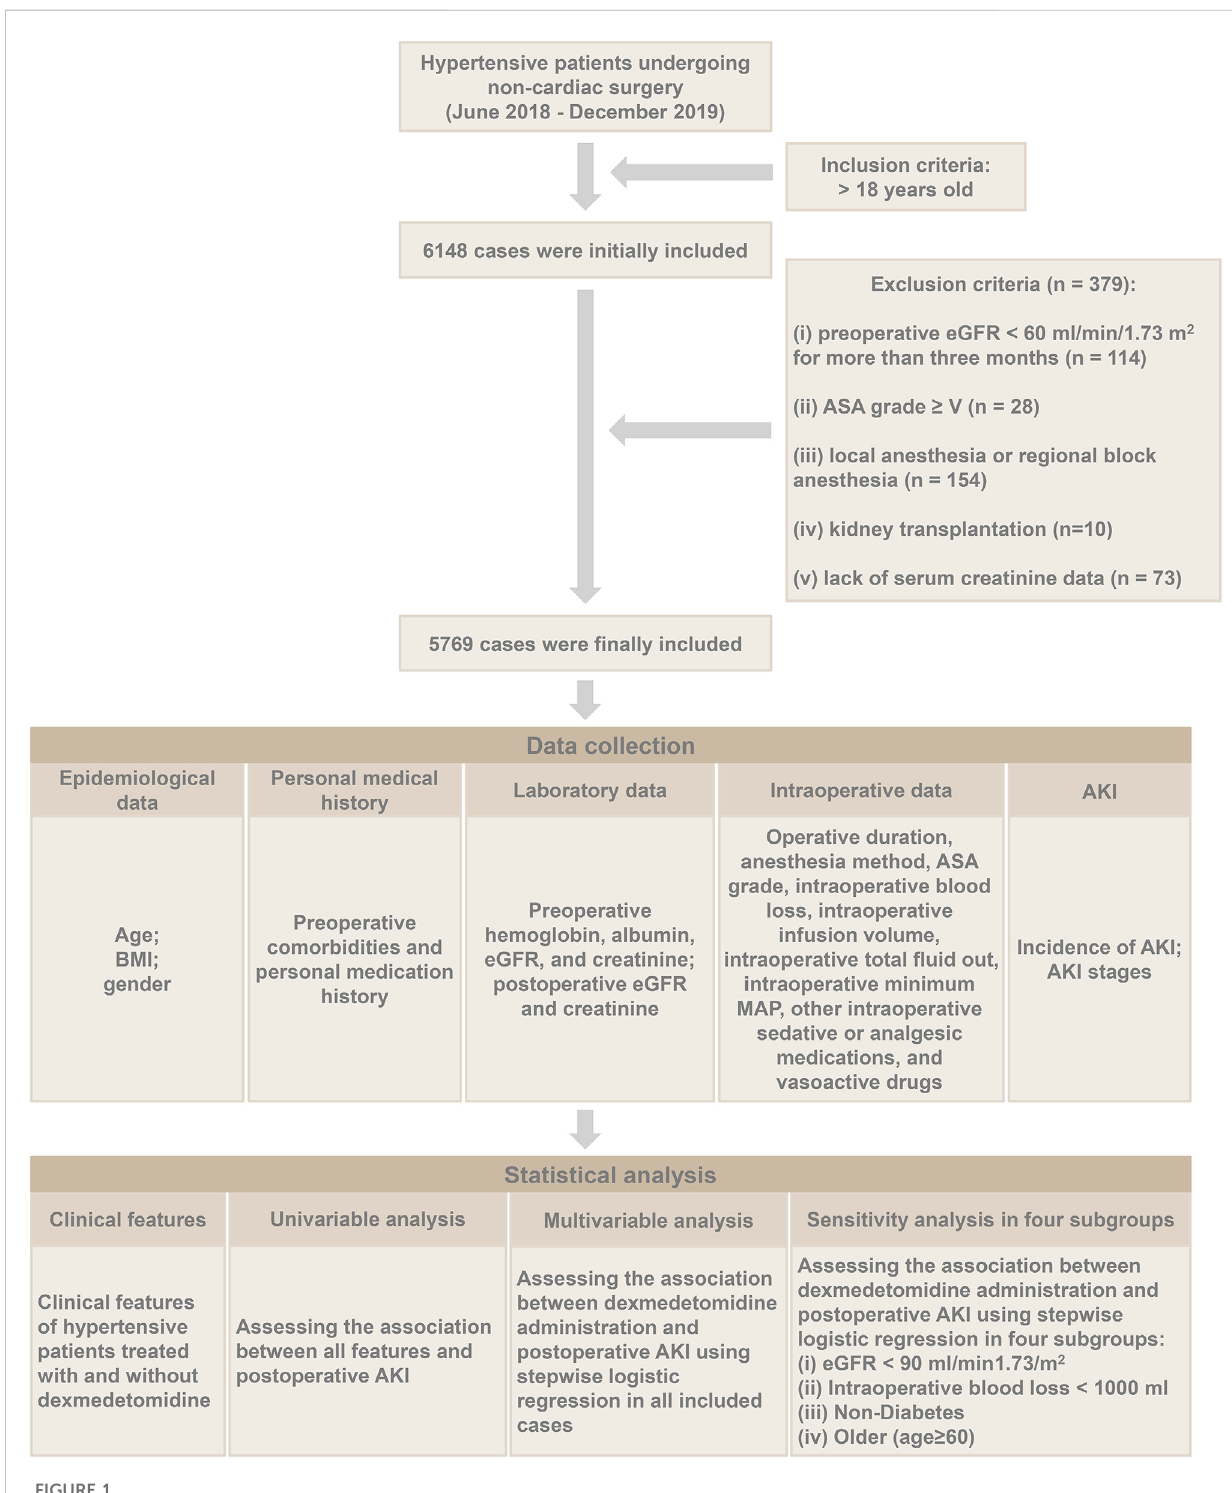
using the median and quartiles (the normality test was performed by Kolmogorov-Smirnov test). In addition, categorical variables were expressed as percentages. Continuous variables were compared between groups using the Wilcoxon rank sum test, and